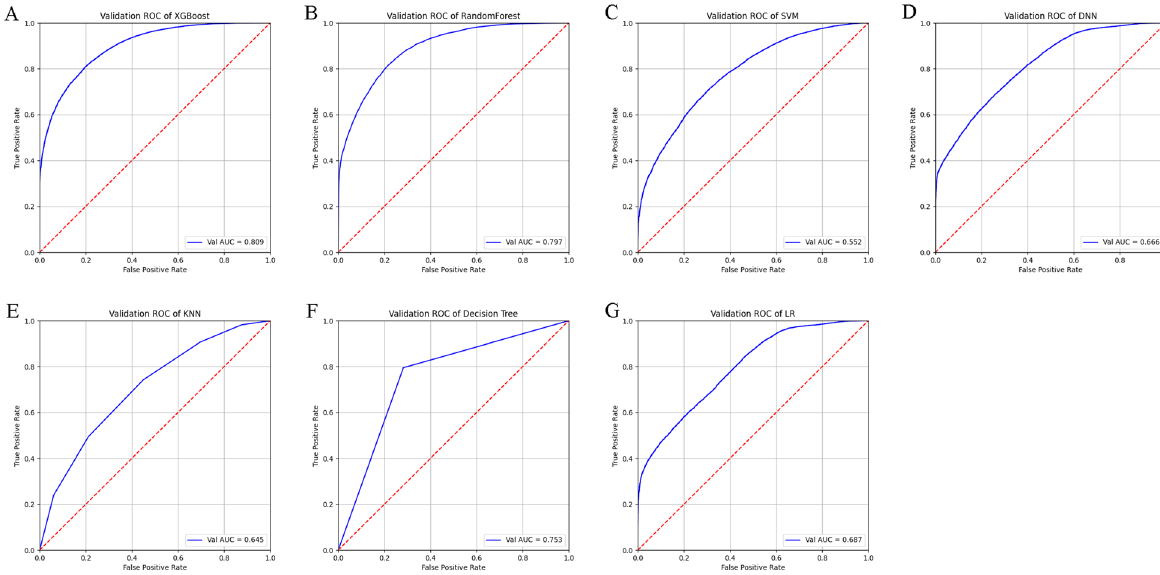
Figure 2. Comparisons of the performance of the seven ML models. The seven ML models were compared against each other based on their ROC curves, and their performances were evaluated by several important metrics such as AUC, accuracy, precision, recall, and f1 score, whose values of Mean and 95% CI were shown in Table S1. ( A ) ROC curves of the XGBoost model, AUC [mean]: 0.809 (0.806–0.811). ( B ) ROC curves of the RF model, AUC [Mean]: 0.797 (0.795–0.800). ( C ) ROC curves of the SVM model, AUC [mean]: 0.552 (0.547– 0.557). ( D ) ROC curves of the DNN model, AUC [mean]: 0.666 (0.607–0.724). ( E ) ROC curves of the KNN